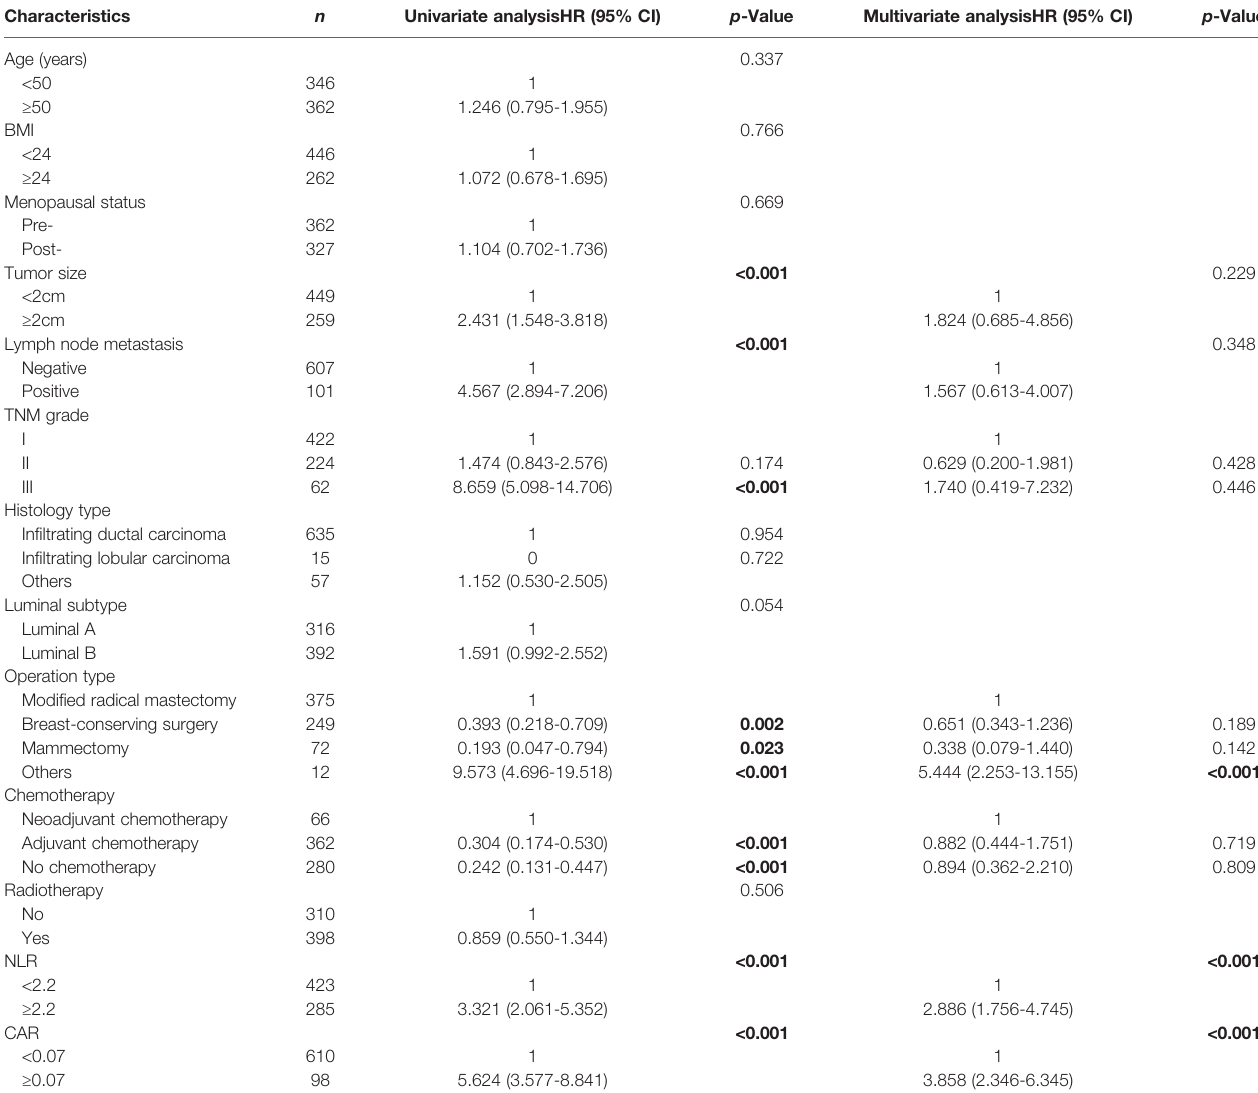
TABLE 4 | Univariable and multivariable analyses of DFS in Luminal BC with HER2-negativity.